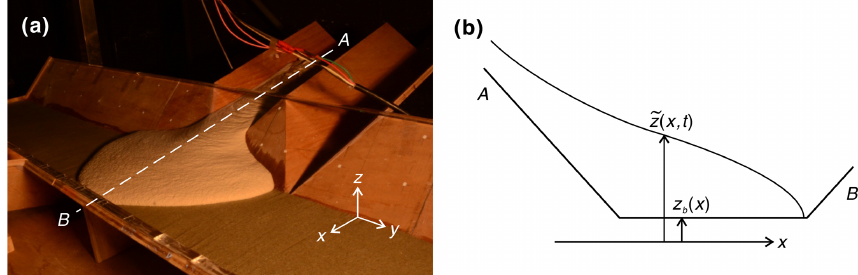
Figure 2. Deposition of a cohesive-frictional material over a substrate of known geometry. (a) Experimental case featuring a symmetric deposit. (b) Schematic section along the deposit